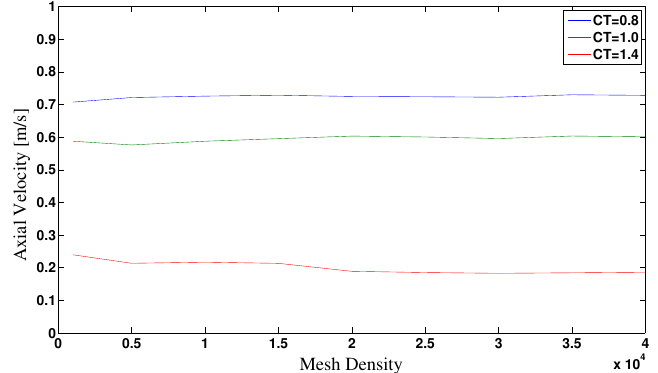
Figure 8. Convergence of the axial velocity value at the disk, with increasing mesh density, for CT = 0.8, CT = 1.0 and CT =